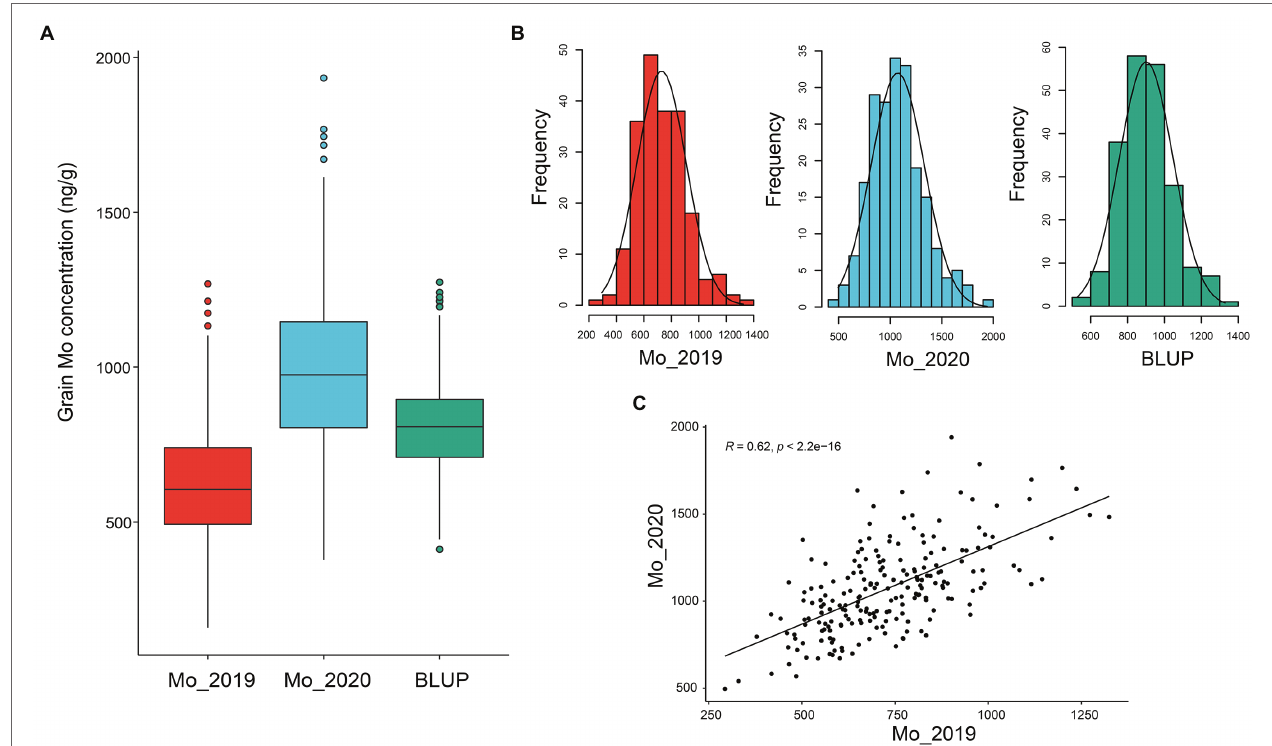
FIGURE 1 | Grain Mo concentration of 207 wheat accessions in 2019 and 2020, and BLUP values. (A) Boxplots of grain Mo concentrations for two single years and BLUP values. (B) Phenotype distribution of grain Mo concentration (ng/g) in the single season (2019 and 2020) and BLUP value. (C) Pearson’s correlation between the two years.